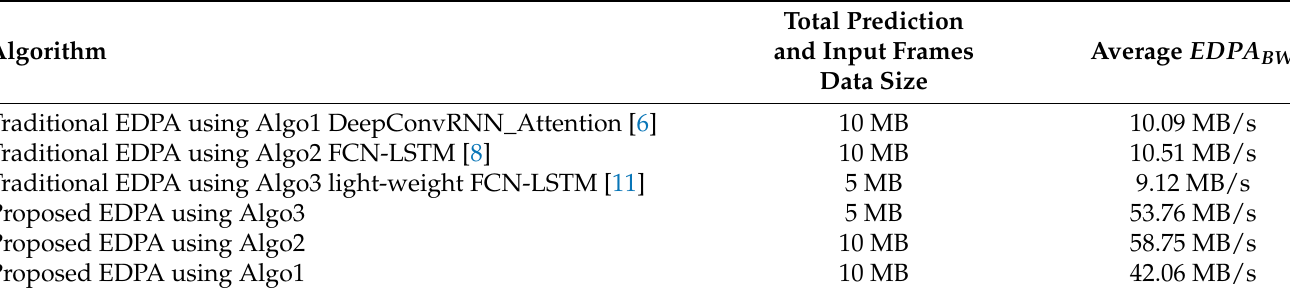
Table 6. The EDPA BW for the driver profiling